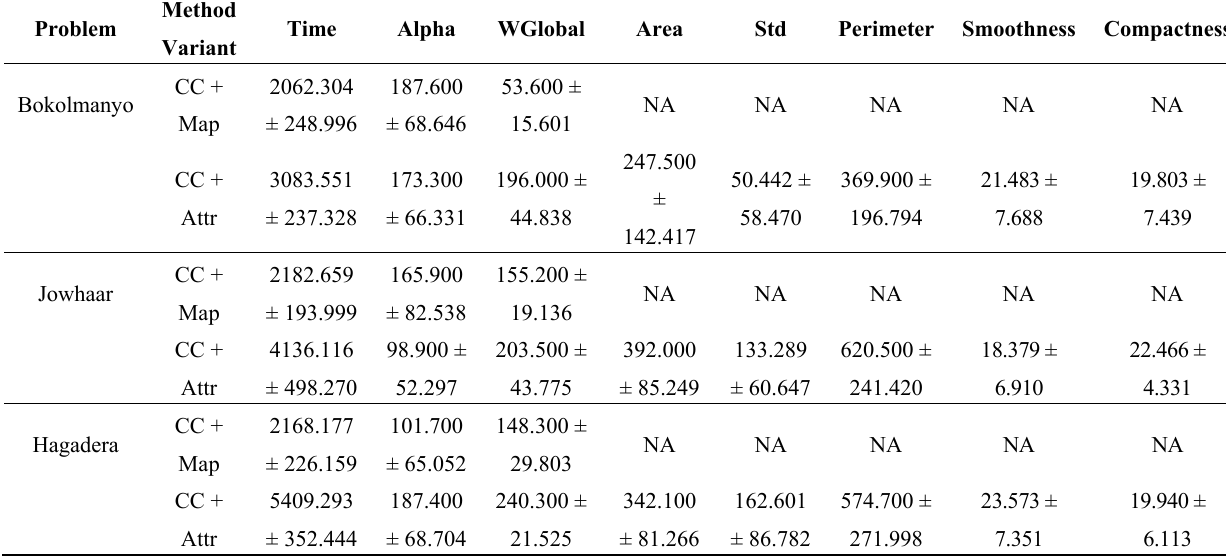
Table 11. Average computing times for experimental runs and resulting method